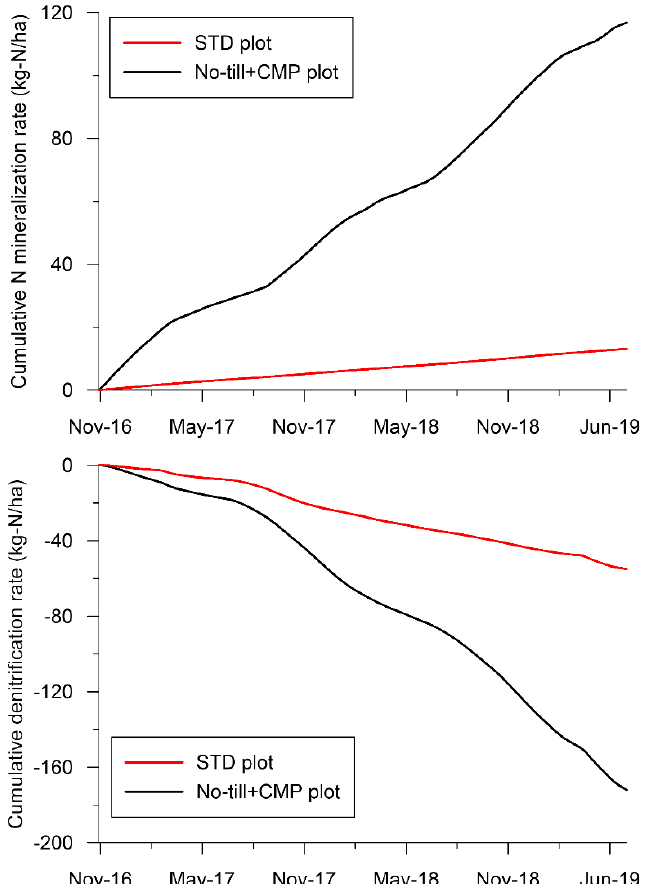
Figure 8. Comparison of the calculated cumulative N mineralization rate (upper panel) and denitrification rate (lower panel) for the No-till + CMP plot (black line) and for the STD plot (red line).